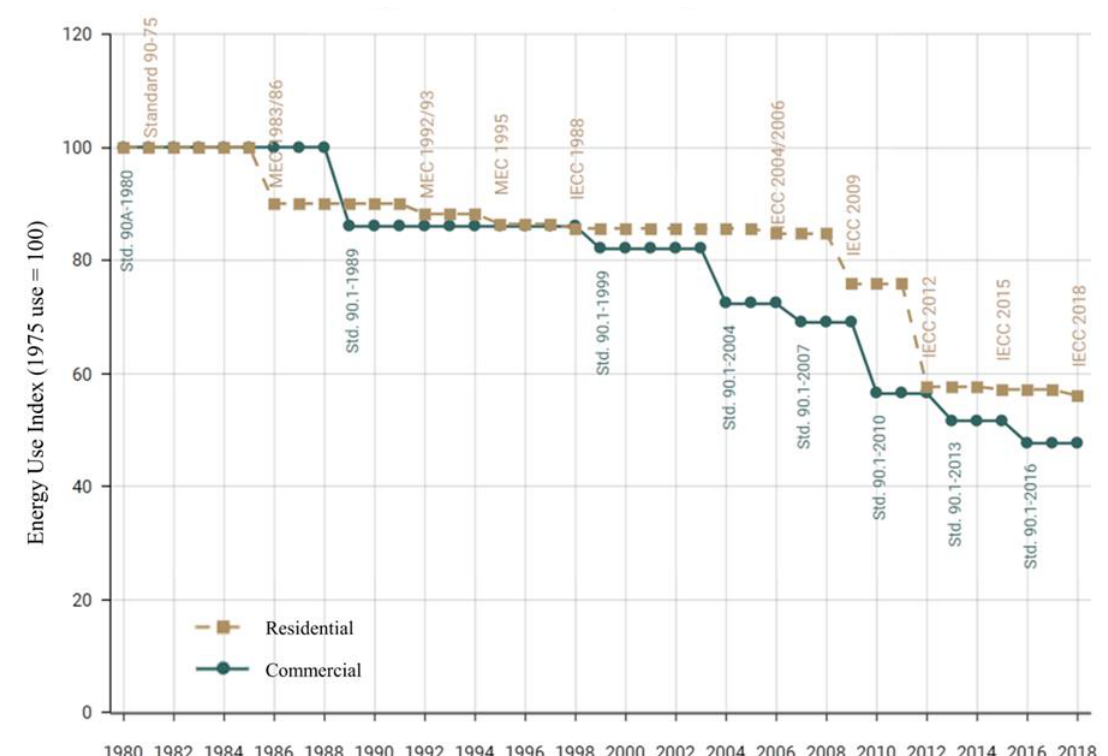
Figure 6. Energy use improvement in commercial and residential standards in the United States from 1975 to 2018 [60]. Table 2. IECC and ASHRAE 90.1 standard improvements compared to their last versions.